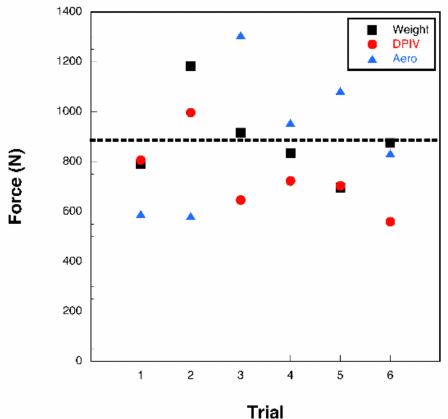
Figure 5. Comparison of the methods of bubble DPIV and aerodynamic analysis for each experimental trial. Symbols represent the weight supported out of the water during a tail stand (black squares), thrust measured using bubble DPIV (red circles), and thrust measured using aerodynamic analysis (blue triangles). The dashed line is the mean weight supported during a tail stand for the six experimental